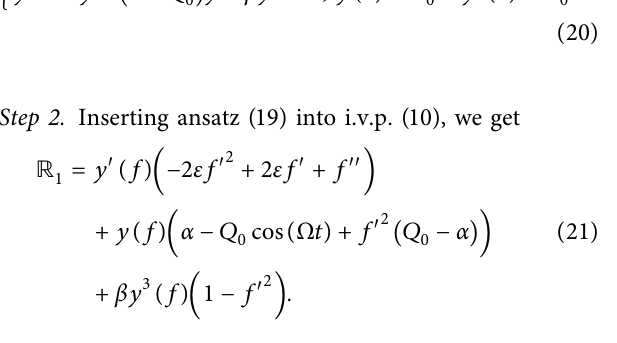
Figure 3: The profile of the approximation (12) using the values of κ ,Q ,x , _ x , 1 , 0 . 1 , 0 . 5 , 0 . 1 , π /6 , 0 . 2 against t for α , β , ε , 0 0 0 ) (cid:29) ( 4 ( Ω